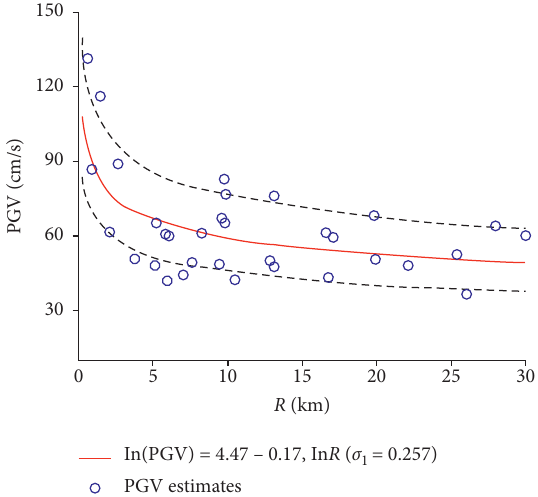
Figure 2: Attenuation of PGV with the rupture fault distance R for the Chi-Chi earthquake (the dashed lines correspond to mean values ± σ 1